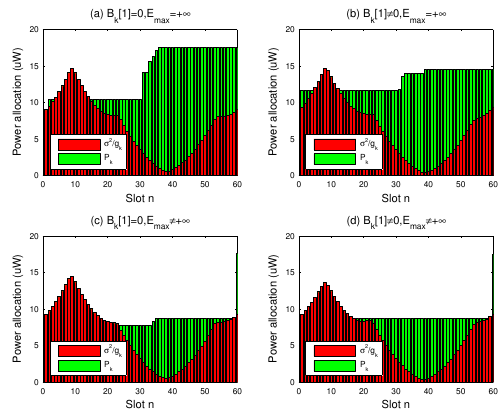
Figure 6. Optimal power allocation at user when T = 60 s.